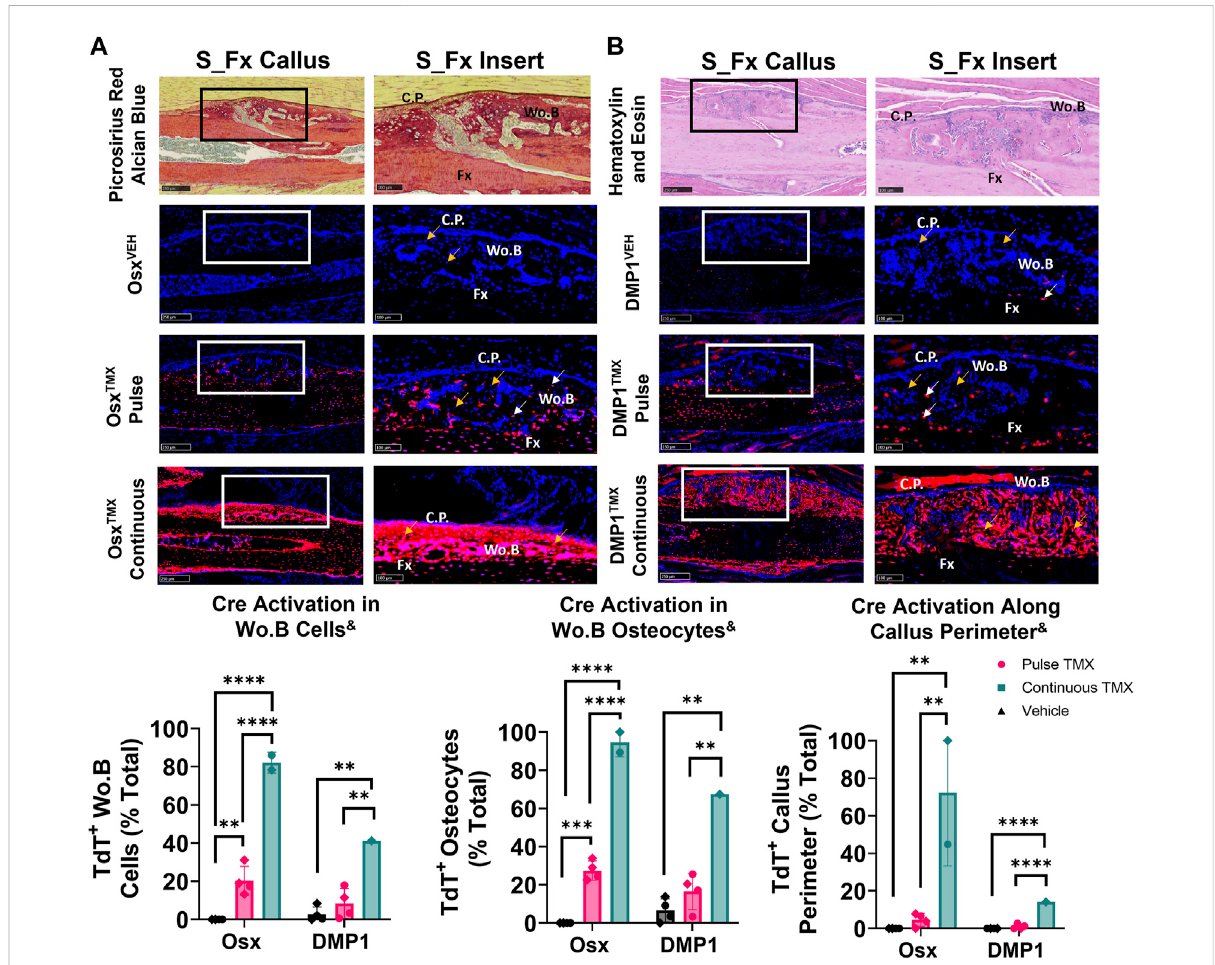
FIGURE 6 Pre-existing Osx + (panel (A) )but not DMP1 + (panel (B) )lineage cells and their progeny signi fi cantly contribute to wovenbone cells during stress fracture. 10X and 20X images (S_Fx insert - scale bar 100 µm) centered around the PID10 stress fracture line (Fx). TdTomato positive cells within the callus were thresholded, counted and normalized to total number DAPI + callus cells (TdT + Wo. B Cells). TdTomato positive Wo. B osteocytes (TdT + Wo. B osteocytes - white arrow) were normalized to total number of osteocytes (TdT + and TdT − osteocytes - orange arrow). TdT + periosteal callusperimeterwasnormalizedtototalcallusperimeterlength(C.P.).Datapresentedasmean±SDwith n =1 – 4pergroup. Mousesexofeachdata point is represented by shape (circle – female; diamond – male). & Signi fi cant Tamoxifen Effect by 1-WAY ANOVA. ** p < 0.005; **** p < 0.00005 Signi fi cantly Different by Tukey